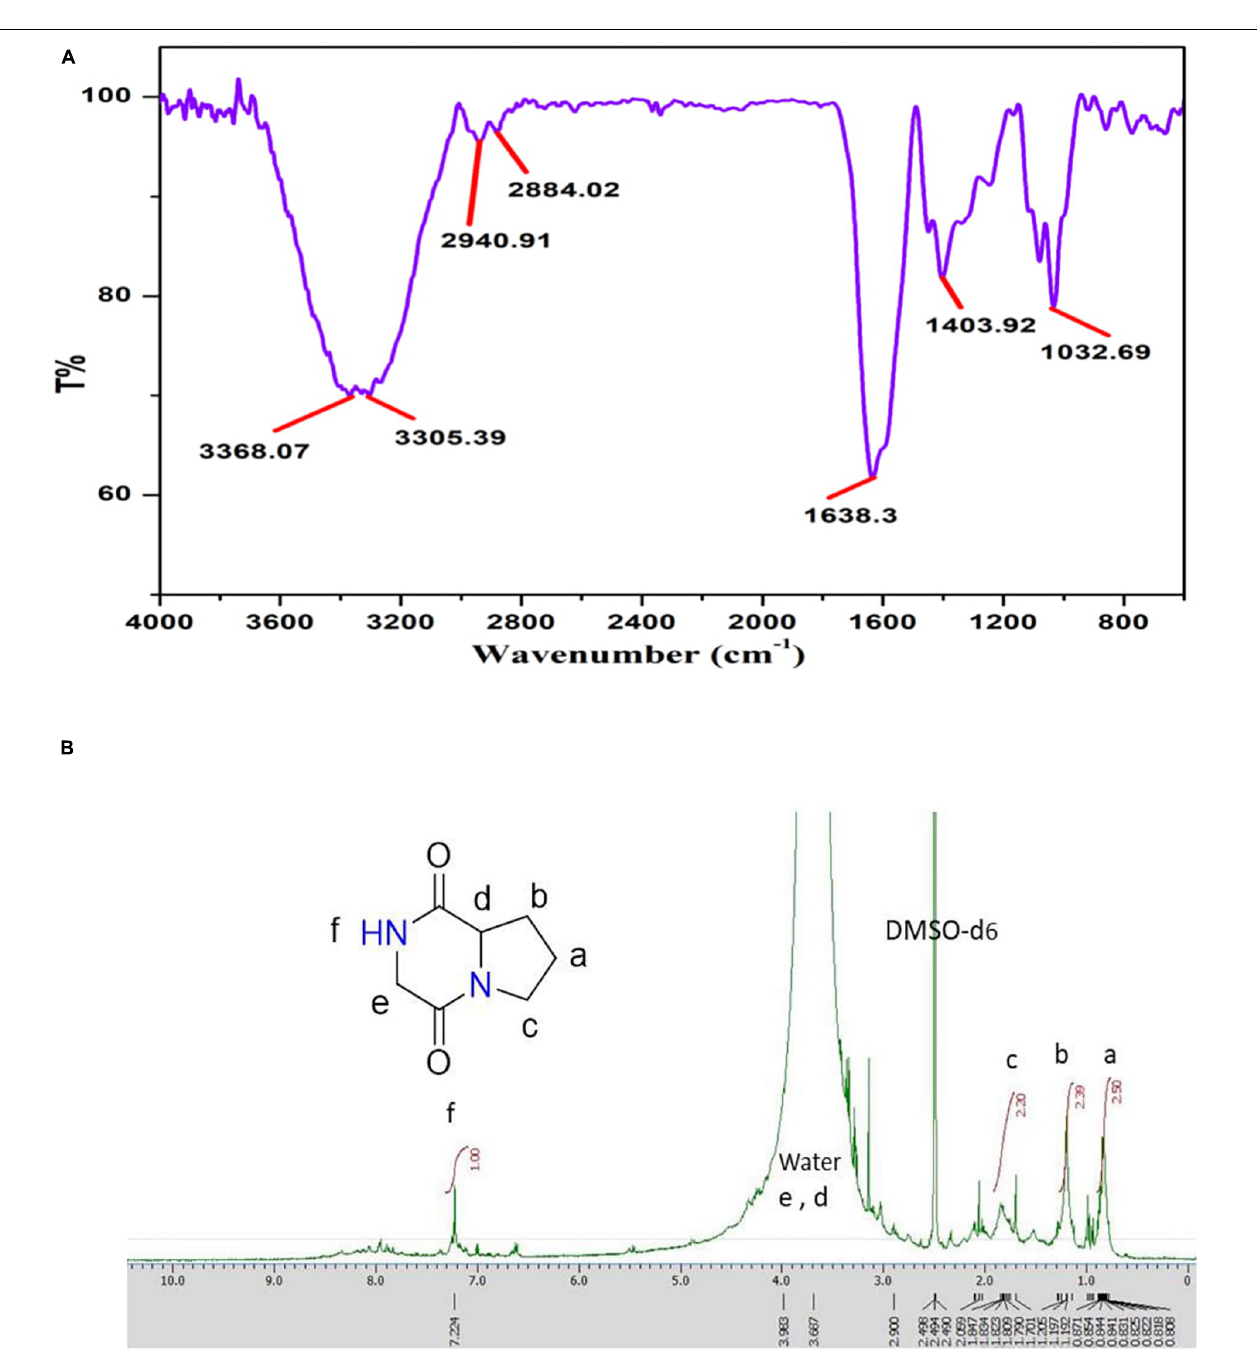
FIGURE 6 | (A) FT-IR spectrum showing stretching frequency of functional groups of compound PPDH. (B) 1 H-NMR spectrum of PPDH.